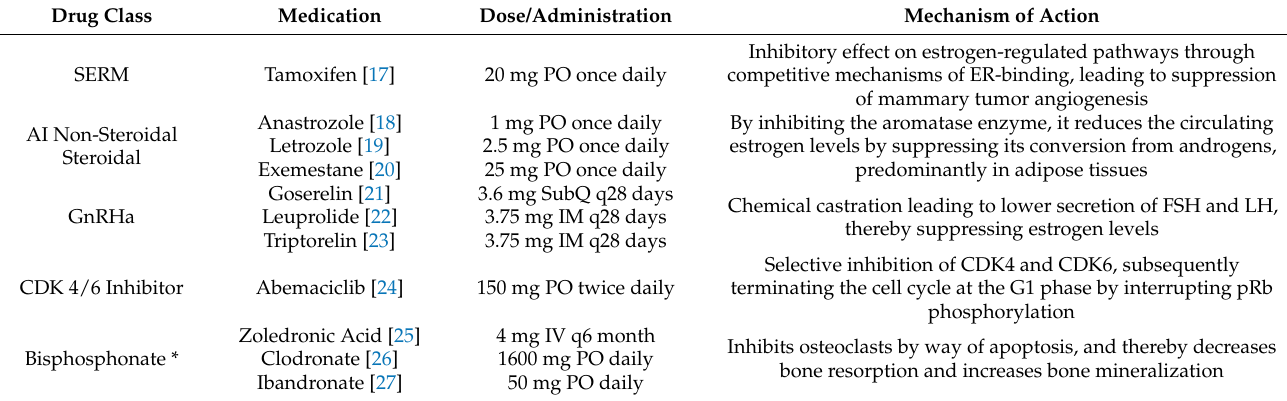
Table 1. Recommended Adjuvant Therapy for Women with ER+ HER2- Breast